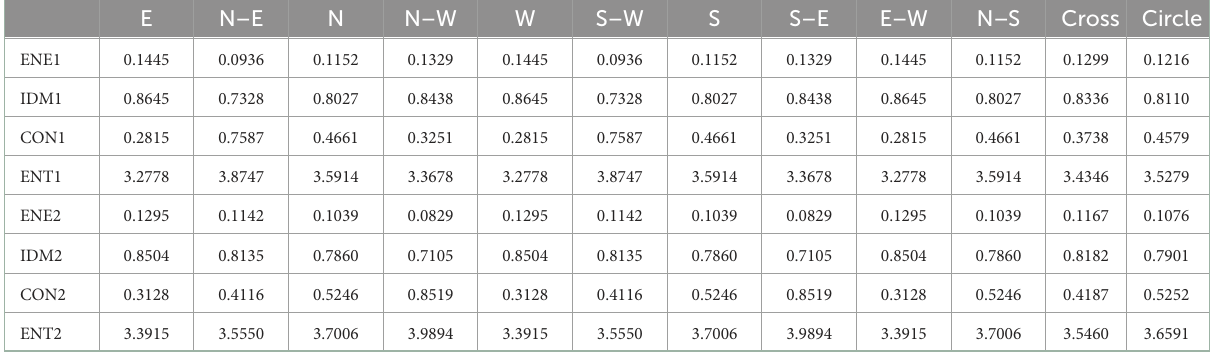
TABLE 4 Relevant calculation data for quantitative analysis of echo homogeneity of white matter in plane one brain.